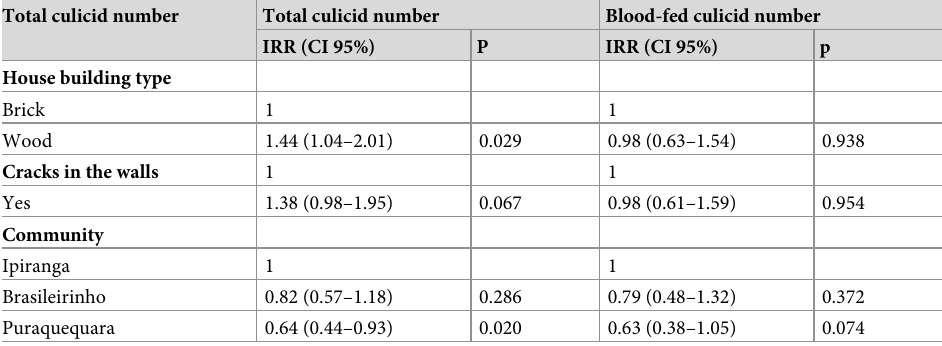
ately associated with the number of total mosquitoes per house (p < 0.0001, R 2 = 0.37). Table 3. Association of house parameters with total number of mosquitoes and number of blood-fed mosquitoes captured during indoor collections (negative binomial